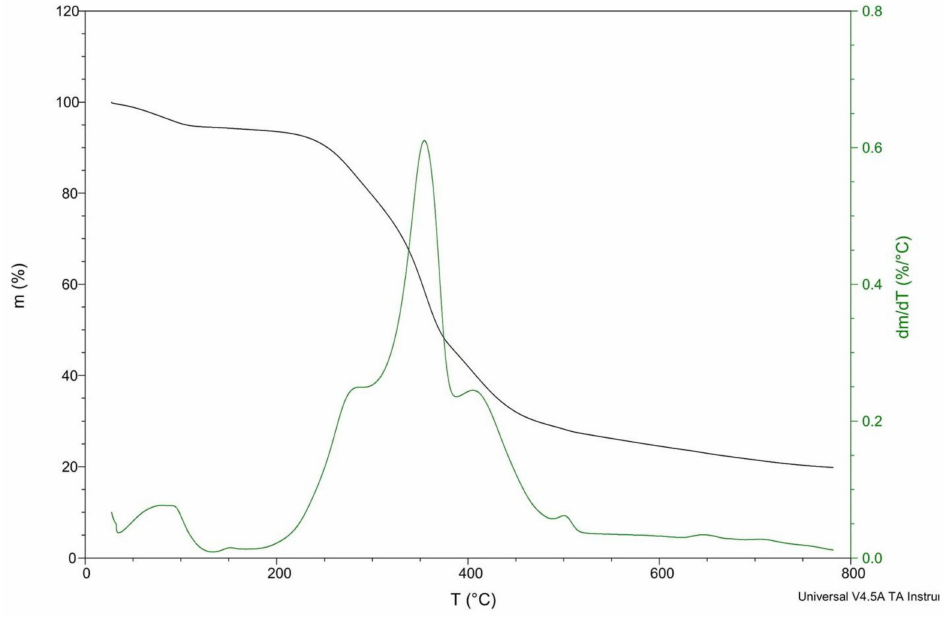
Figure 7. Thermogravimetric curves for cortex